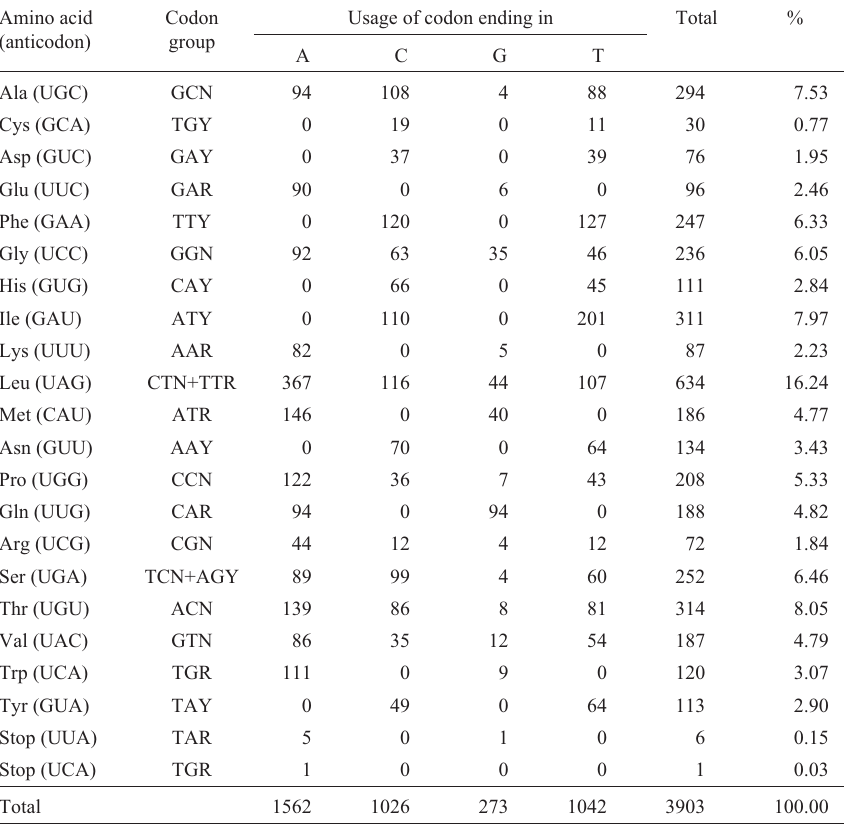
Table 3 - Codon usage of the Arapaima gigas